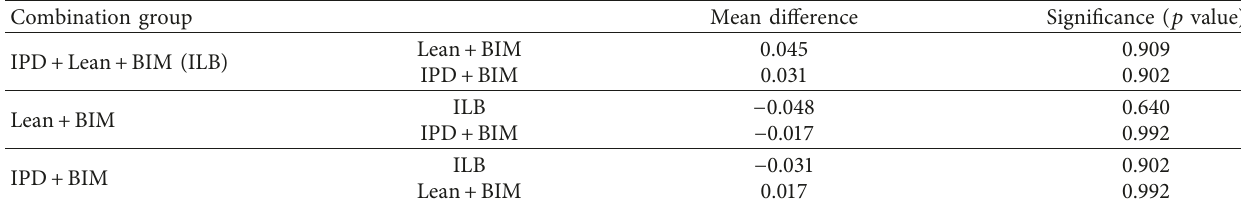
Table 4: Pairwise comparisons of combination groups in terms of cost performance.